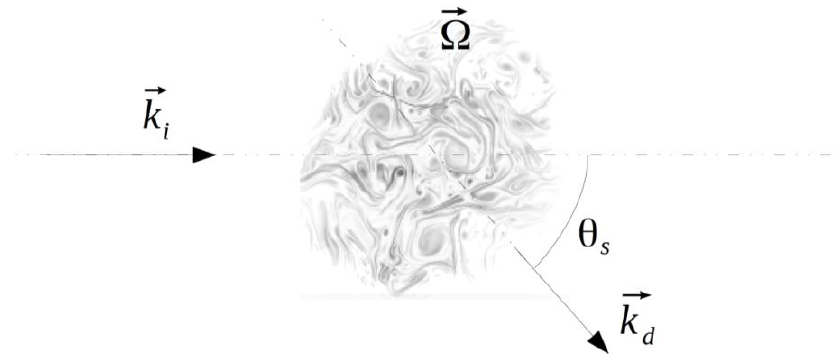
Figure 4. Observation angle of the scattered